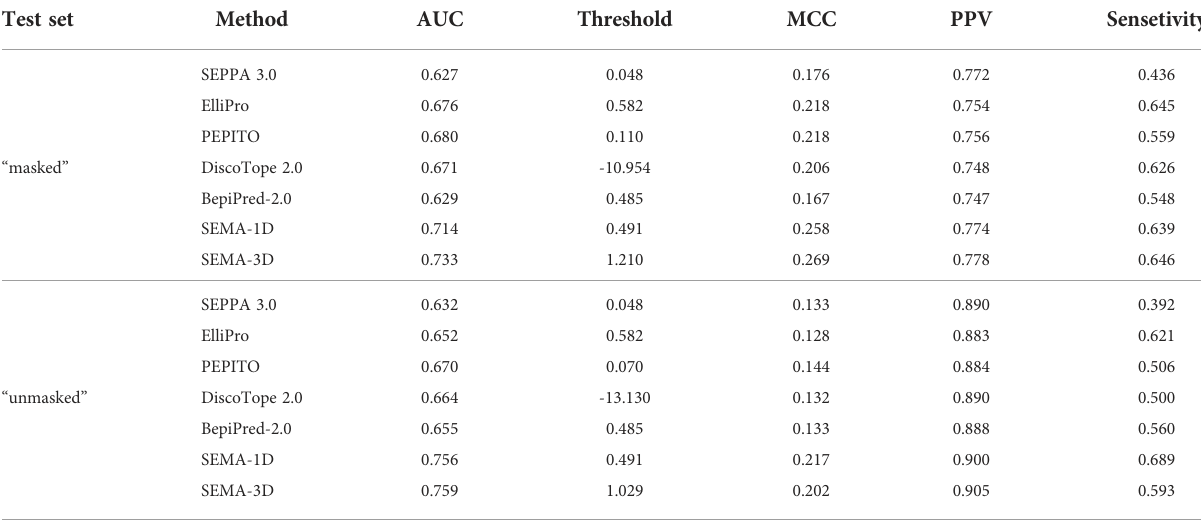
TABLE 1 Performance comparison of SEMA-1D and SEMA-3D with other peer methods on two test sets: “ masked ” ( R 1 = 4.5 Å; R 2 = 16.0 Å) and “ unmasked ” ( R 1 = 4.5 Å; R 2 = In fi nite ). Test